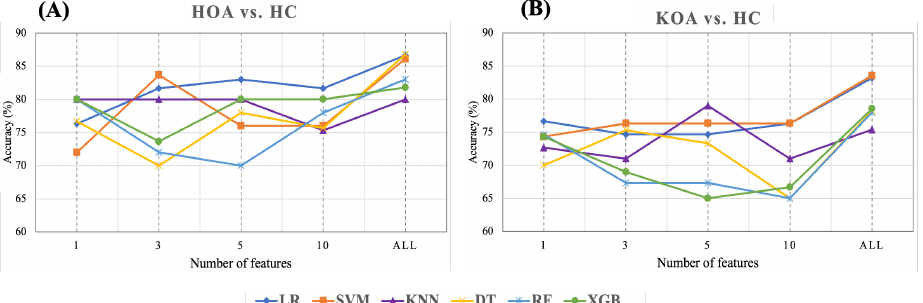
Figure 18. Accuracy of ML with top 1, 3, 5, 10, all STGP features for ( A ) HOA vs. HC and ( B ) KOA vs. HC.